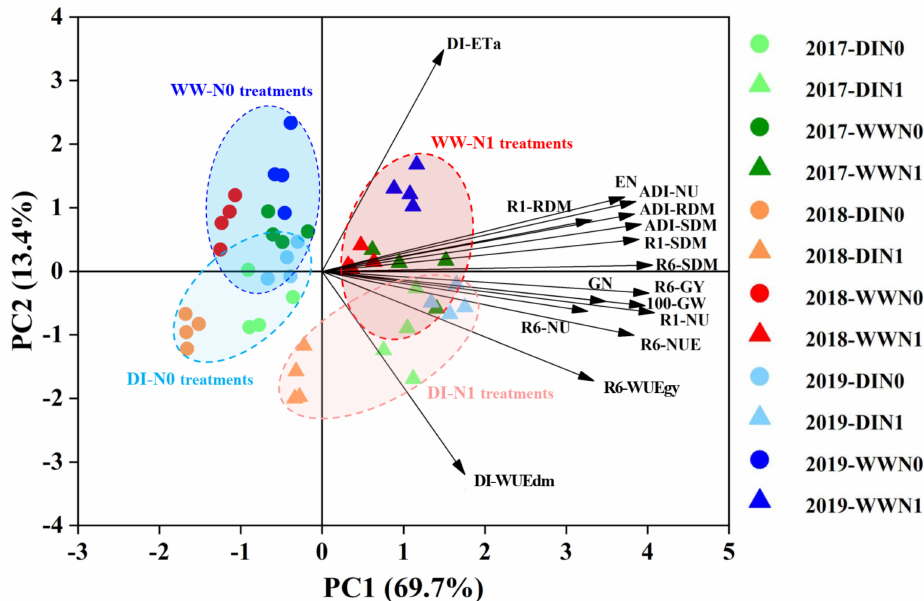
Figure 6. Principal component analysis (PCA) biplot of maize growth and water and N use parameters at different periods under various nitrogen and seedling-stage soil water managements in